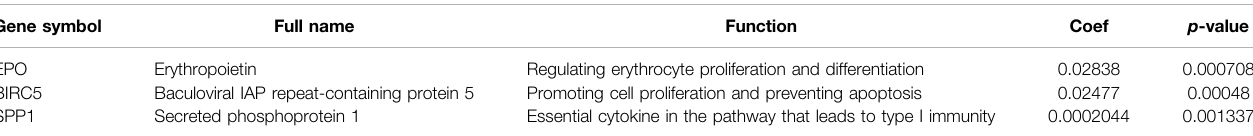
TABLE 1 | Biological functions and marker coef fi cient of key